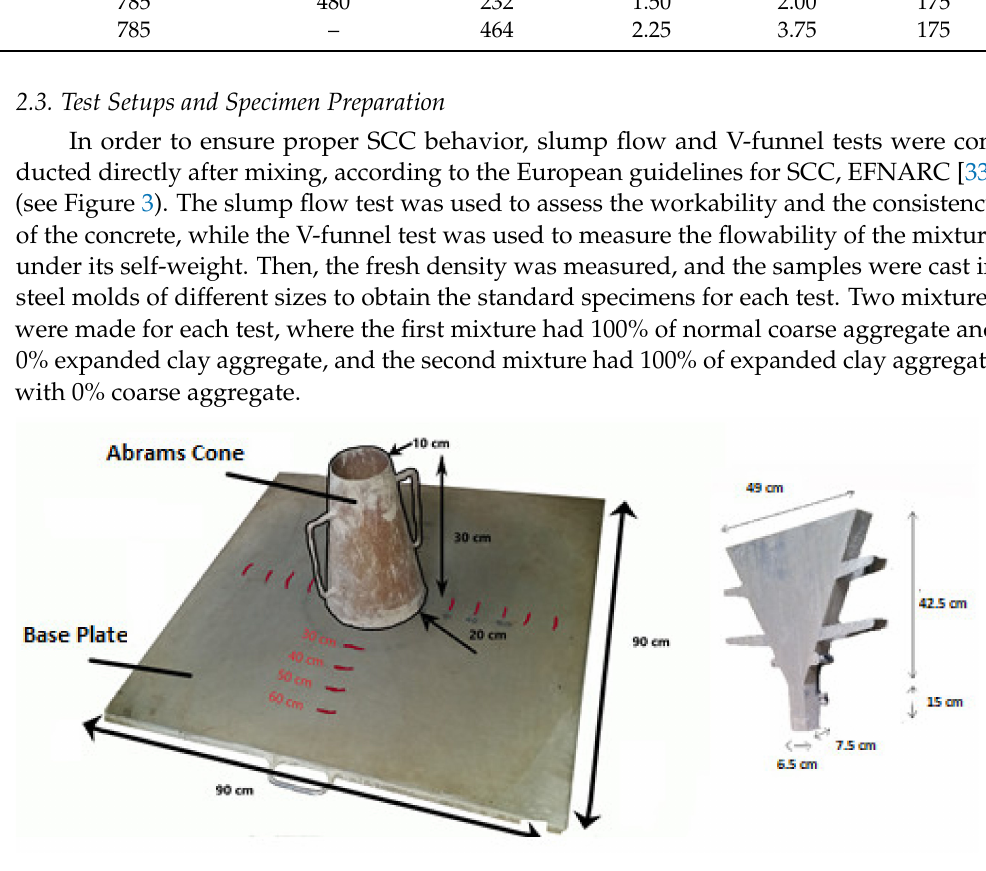
Figure 3. Equipment for slump flow and V-funnel